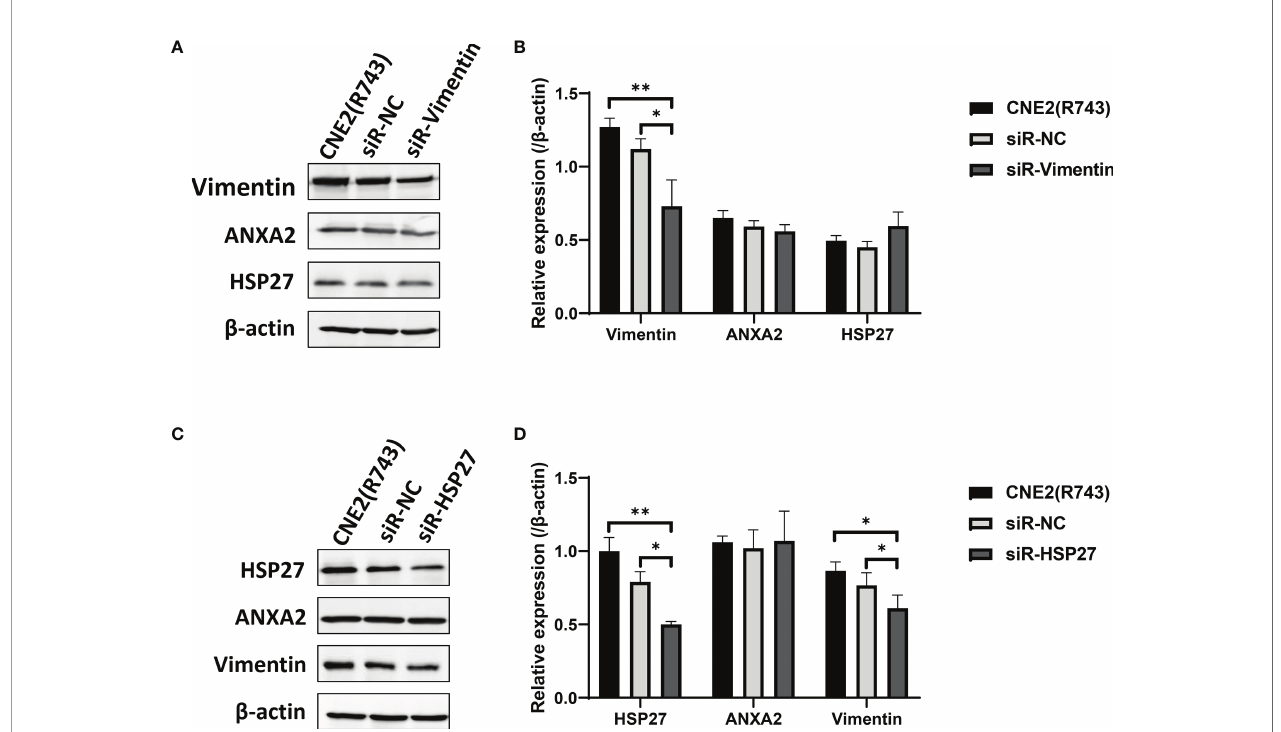
FIGURE 6 | Downregulation of Vimentin and HSP27 expression has no impact on ANXA2 expression. (A) Western blotting determines the expression of ANXA2 and ANXA2-interacting proteins HSP27 and Vimentin in siR-Vimentin-, siR-NC- (Negative control siRNA) and non-transfected radioresistant CNE2(R743) cells, and b - actin serves as a loading control; (B) densitometric analysis determines lower Vimentin expression in siR-Vimentin-transfected CNE2(R743) cells than in siR-NC- and non-transfected CNE2(R743) cells, and no signi fi cant difference was seen in ANXA2 or HSP27 expression among the siR-Vimentin-, siR-NC- and non-transfected CNE2(R743) cells; (C) Western blotting determines the expression of ANXA2 and ANXA2-interacting proteins HSP27 and Vimentin in siR-HSP27-, siR-NC- and non- transfected radioresistant CNE2(R743) cells, and b -actin serves as a loading control; (D) densitometric analysis determines lower Vimentin and HSP27 expression in siR-HSP27-transfected CNE2(R743) cells than in siR-NC- and non-transfected CNE2(R743) cells, and no signi fi cant difference was seen in ANXA2 expression among the siR-HSP27-, siR-NC- and non-transfected CNE2(R743) cells. All values are presented as mean ± SD, n = 3. * P < 0.05, ** P <